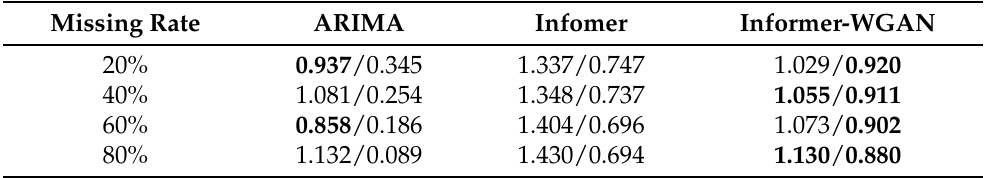
Table 8. The RMSE/Pearson correlation results of the informer-WGAN and other imputation results on electricity dataset.